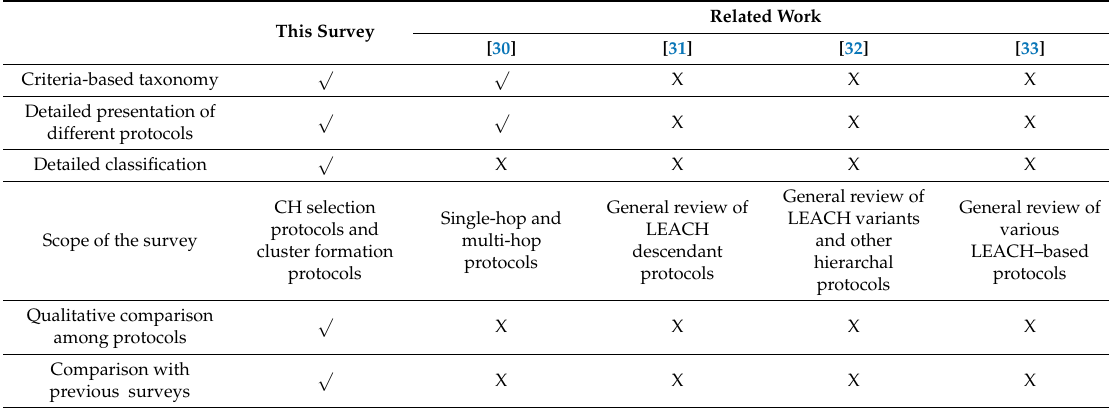
Table 12. Comparison of this survey with existing